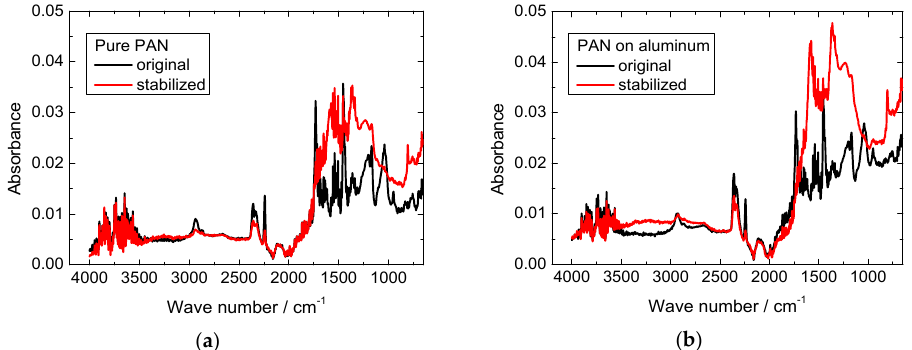
Figure 4. FTIR investigation of PAN nanofiber mats before and after stabilization: ( a ) pure PAN; ( b ) PAN on aluminum substrate.